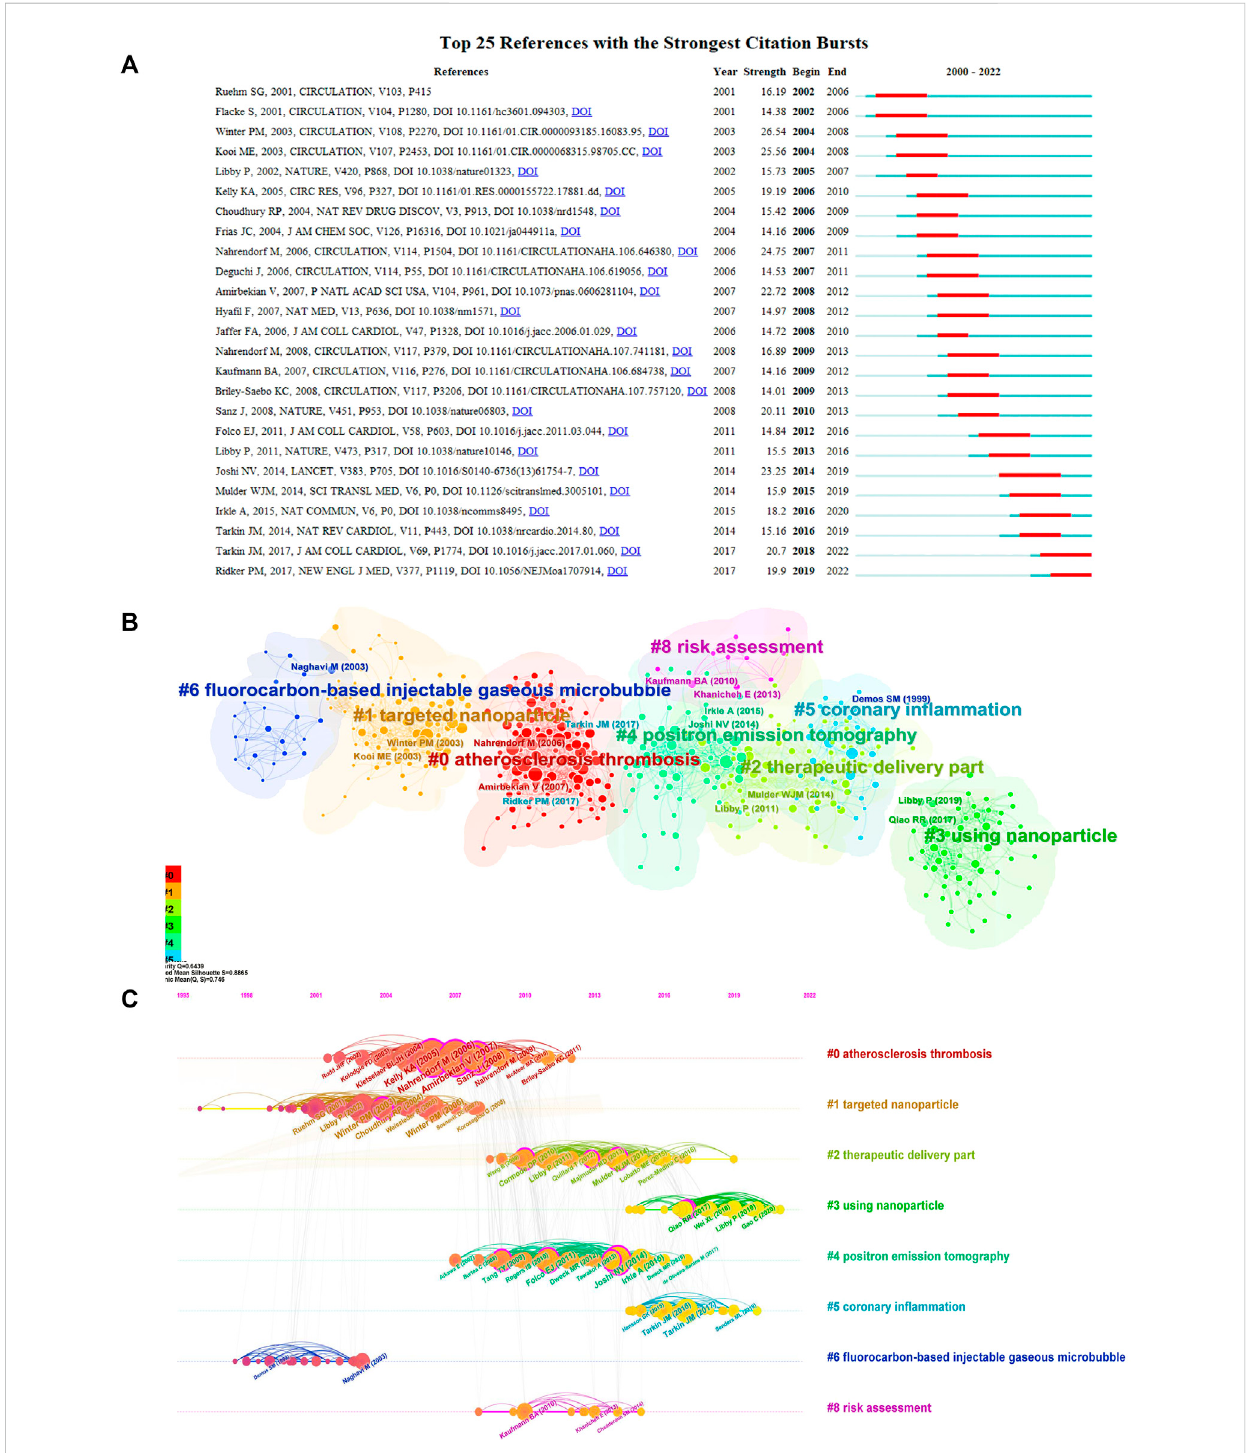
FIGURE 8 (A) CiteSpacevisualizationofthetop25referenceswiththestrongestcitationburstsfrom2000to2022. (B)